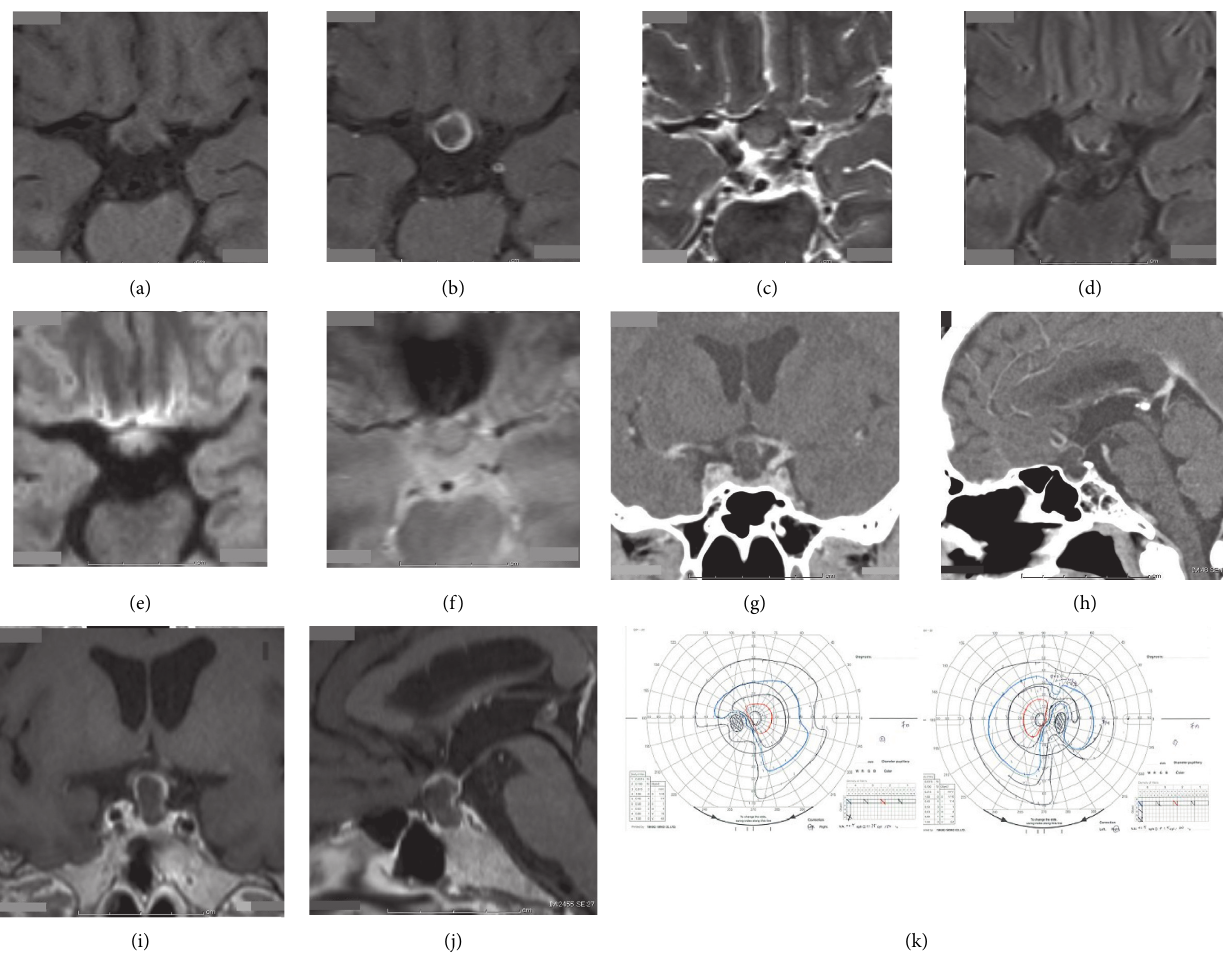
Figure 1: Precontrast T1-weighted axial image showing a suprasellar tumor compressing the optic pathway (a). Gadolinium-enhanced axial image showing an enhanced rim of the tumor (b). The contents of the tumor are of low signal intensity on the T1-weighted image (a) and Gadolinium-enhanced image (b), slightly high on T2-weighted image (c), iso on fluid-attenuated inversion recovery image (d), and relatively high on diffusion-weighted image (e) and T2 ∗ -weighted image (f). Contrast-enhanced computed tomography showing a cystic lesion (g) from the sella turcia to the suprasellar space (h). Calcified components are not found in it. Postcontrast magnetic resonance imaging shows the enhanced cystic wall displacing the optic chiasm upward (i). This cystic lesion occupies the suprasellar region but not the third ventricle (h), (j). Goldmann perimeter reveals irregular bitemporal hemianopsia (k). Constriction of the visual field is more pre- dominant in the right eye than in the left eye